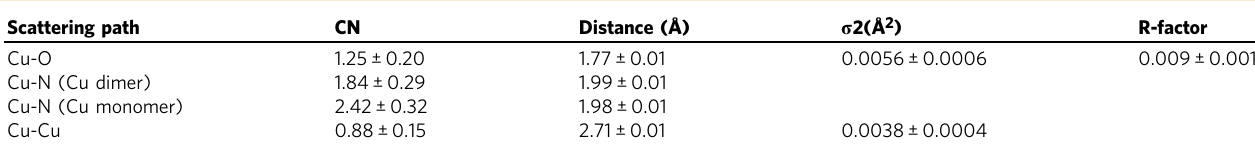
Fig. 2 Characterization of the Cu 2 @C 3 N 4 catalysts. a XPS spectrum at the N 1 s edge and the corresponding deconvolution. b XANES spectra and ( c ) k 2 - weighted EXAFS spectra at the Cu K edge, with Cu foil, Cu 2 O, CuO, and Cu-TPP (one Cu coordinated with for N atoms) as the reference. d Fitting of the EXAFS spectrum with consideration of both monomeric and dimeric Cu sites. e The simulated s t ructure model of dicopper-oxo center. f Geometric parameters of the dicopper-oxo center determined for Cu 2 @C 3 N 4 . Table 1 Structural parameters being used to fi t the EXAFS spectrum for Cu 2 @C 3 N 4 with consideration of both monomeric and dimeric Cu